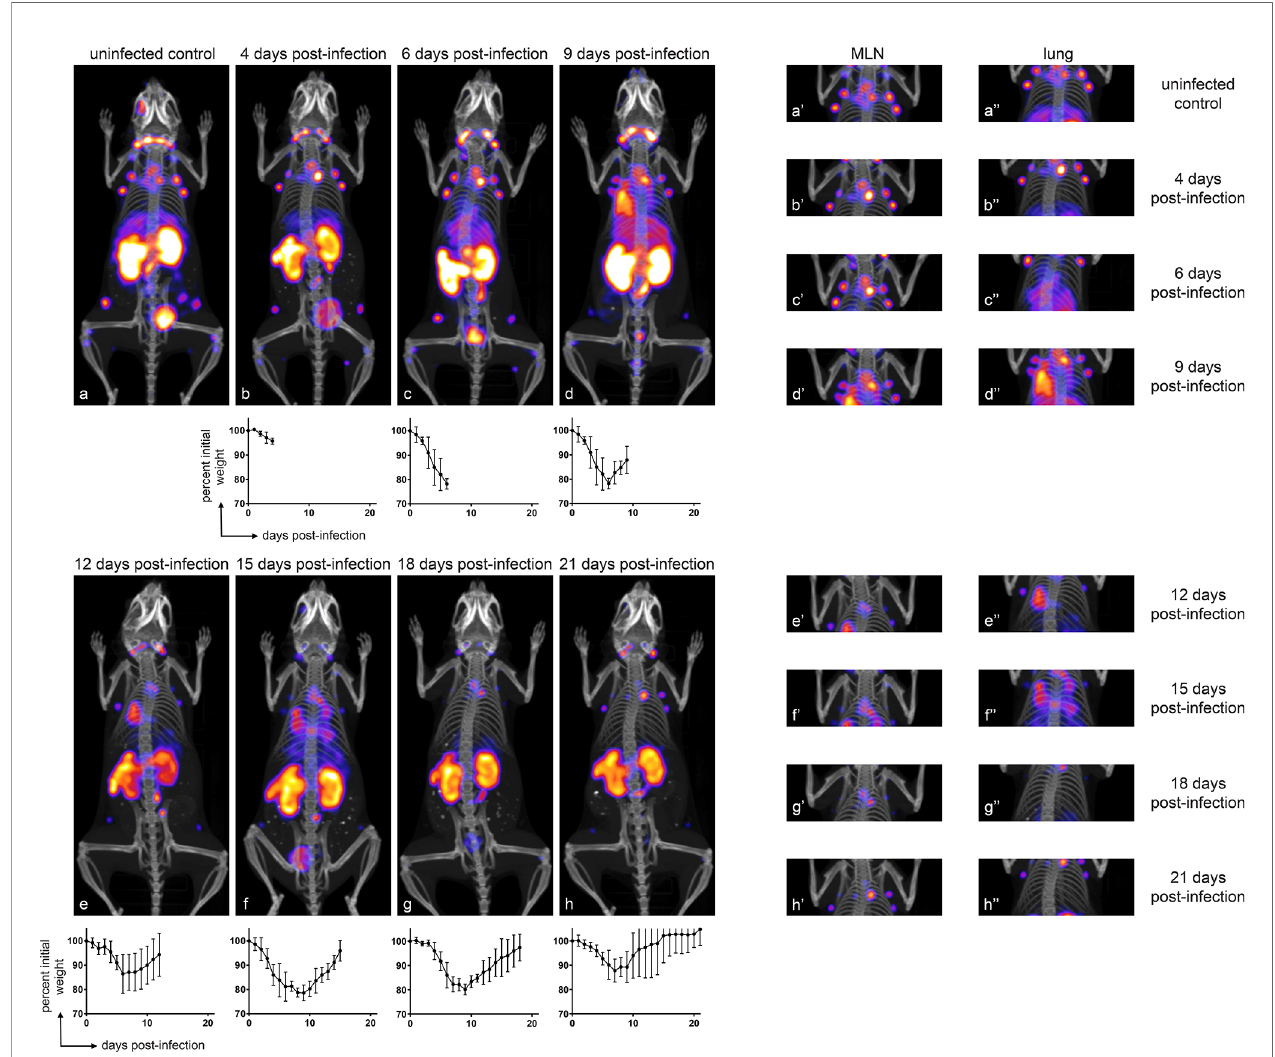
FIGURE 2 | CD8 + T Cells Transiently Accumulate in the Lungs and MLN of IAV-Infected Mice, Correlating with Morbidity. Representative (n ≥ 3) immuno-PET images of IAV WSN/33-infected mice (facing down) injected with 89 Zr-labeled VHH-X118-PEG 20 on the indicated dpi. Graphs below immuno-PET images show percent initial weight for each day over the course of IAV infection for the cohort of animals. Insets to the right depict focused images of the MLN and lungs at the times indicated. Lower case letters link inset images to their corresponding full-body image, and single and double apostrophes indicate MLN and lung insets,